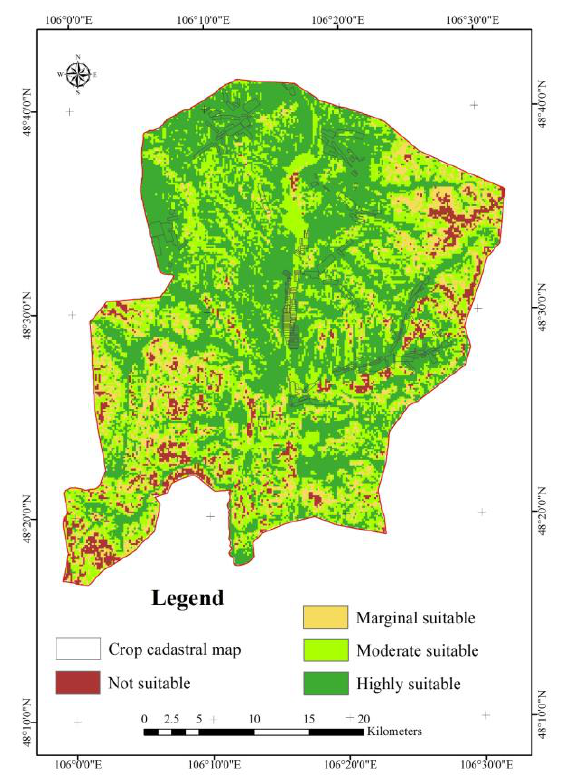
Figure 5. The output map of the cropland suitability in Bornuur